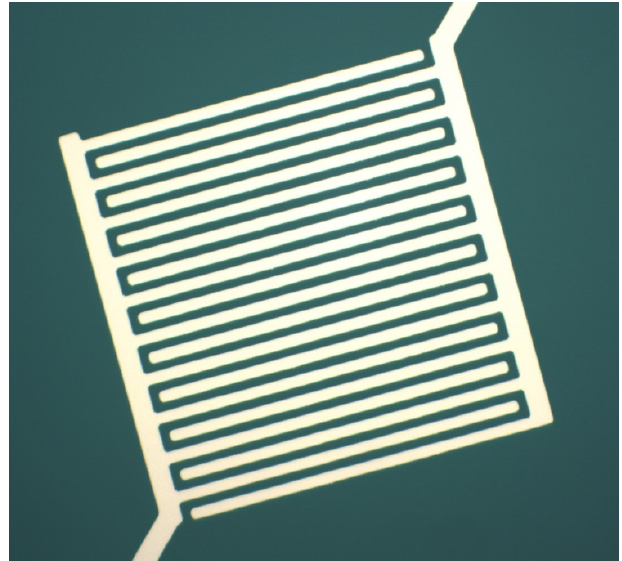
Figure 1. Microfabricated Pt/Ti platinum interdigitated electrodes (IDE) with 10 μ m of both the width of the electrodes and the space between electrodes.